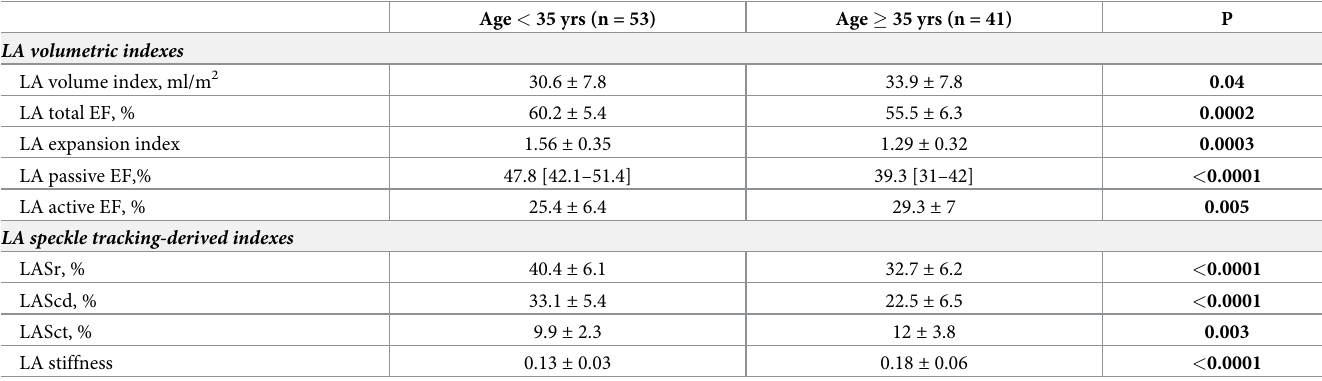
Table 3. Left atrial volumetric and functional